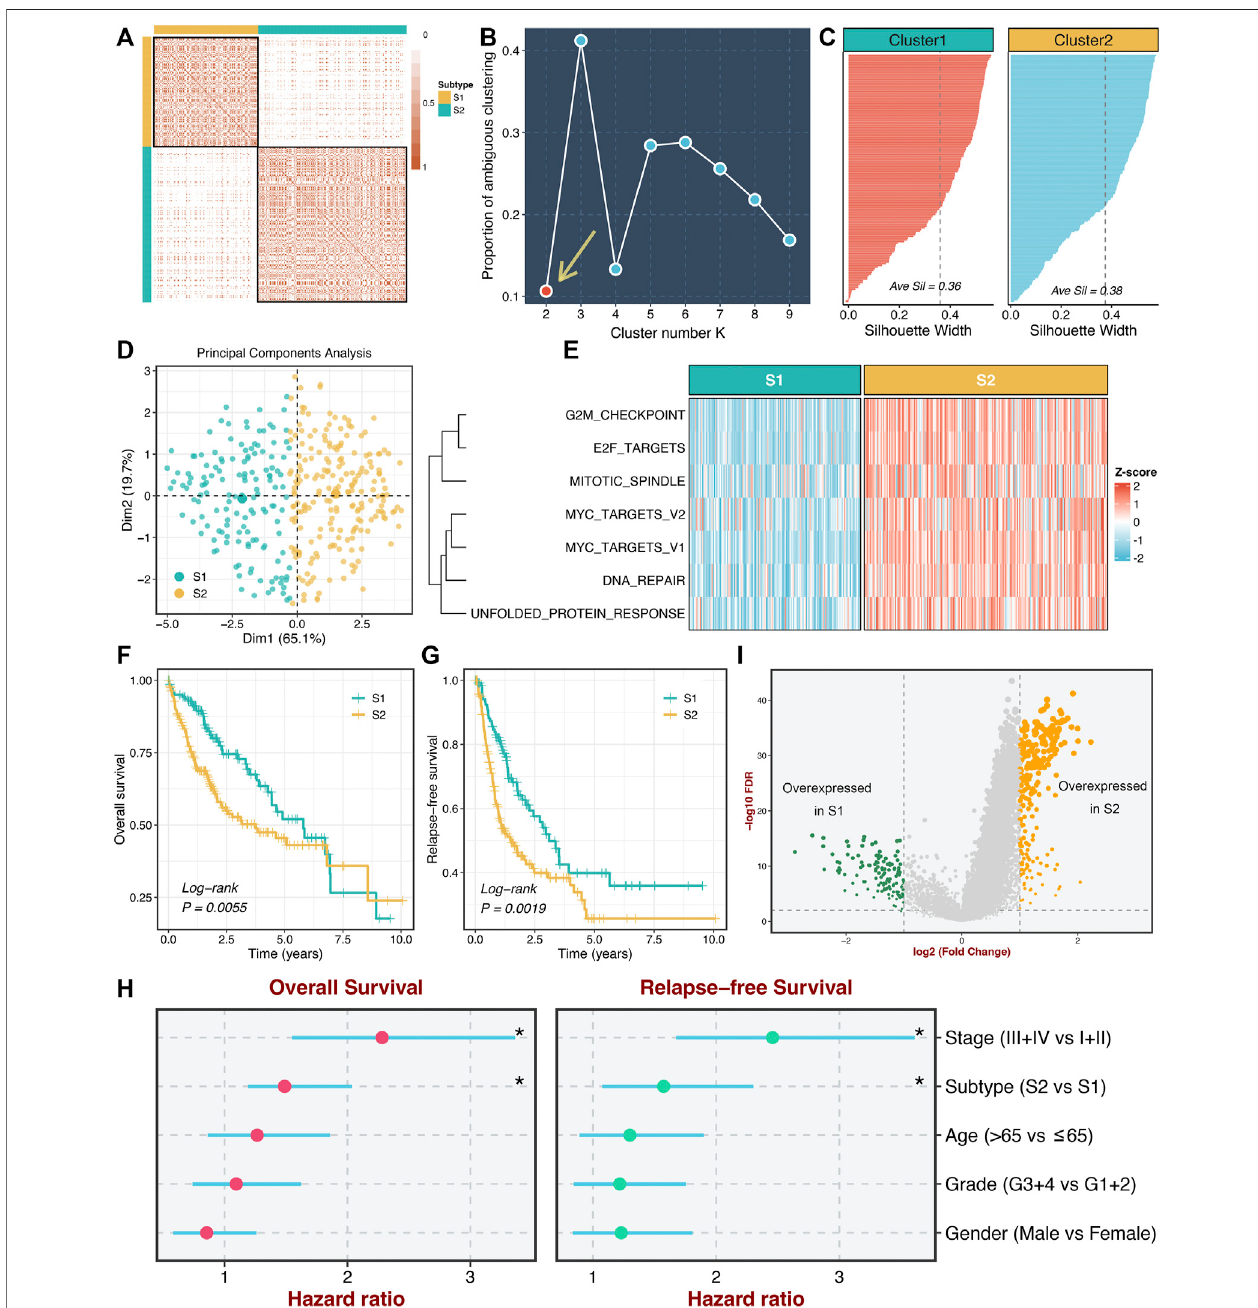
FIGURE 2 | Identi fi cation of two heterogeneous proliferation-related subtypes. (A) The consensus score matrix of all samples when k = 2. Consistent scores between the two samples were positively correlated with the probability that they were grouped into the same cluster in different iterations. (B) The proportion of ambiguousclustering(PAC)score(k=2wasthemostsuitablekvalue). (C) Thesilhouettestatisticofthehigh-andlow-riskgroups. (D) Theprincipalcomponentanalysis (PCA) algorithm showed the two-dimension spatial distribution of the high- and low-risk groups were shown by the principal component analysis (PCA) algorithm. (E) Heatmap displayed that S2 possessed a signi fi cantly higher proliferative quantity compared to S1. (F,G) The Kaplan-Meier plots of OS (F) and RFS (G) of the high- and low-riskgroups. (H) MultivariateCoxregression ofOSand RFS. * p < 0.05. (I) Differentiallyexpressed analysisoflncRNAsbetweentwosubtypes intheTCGA-LIHC